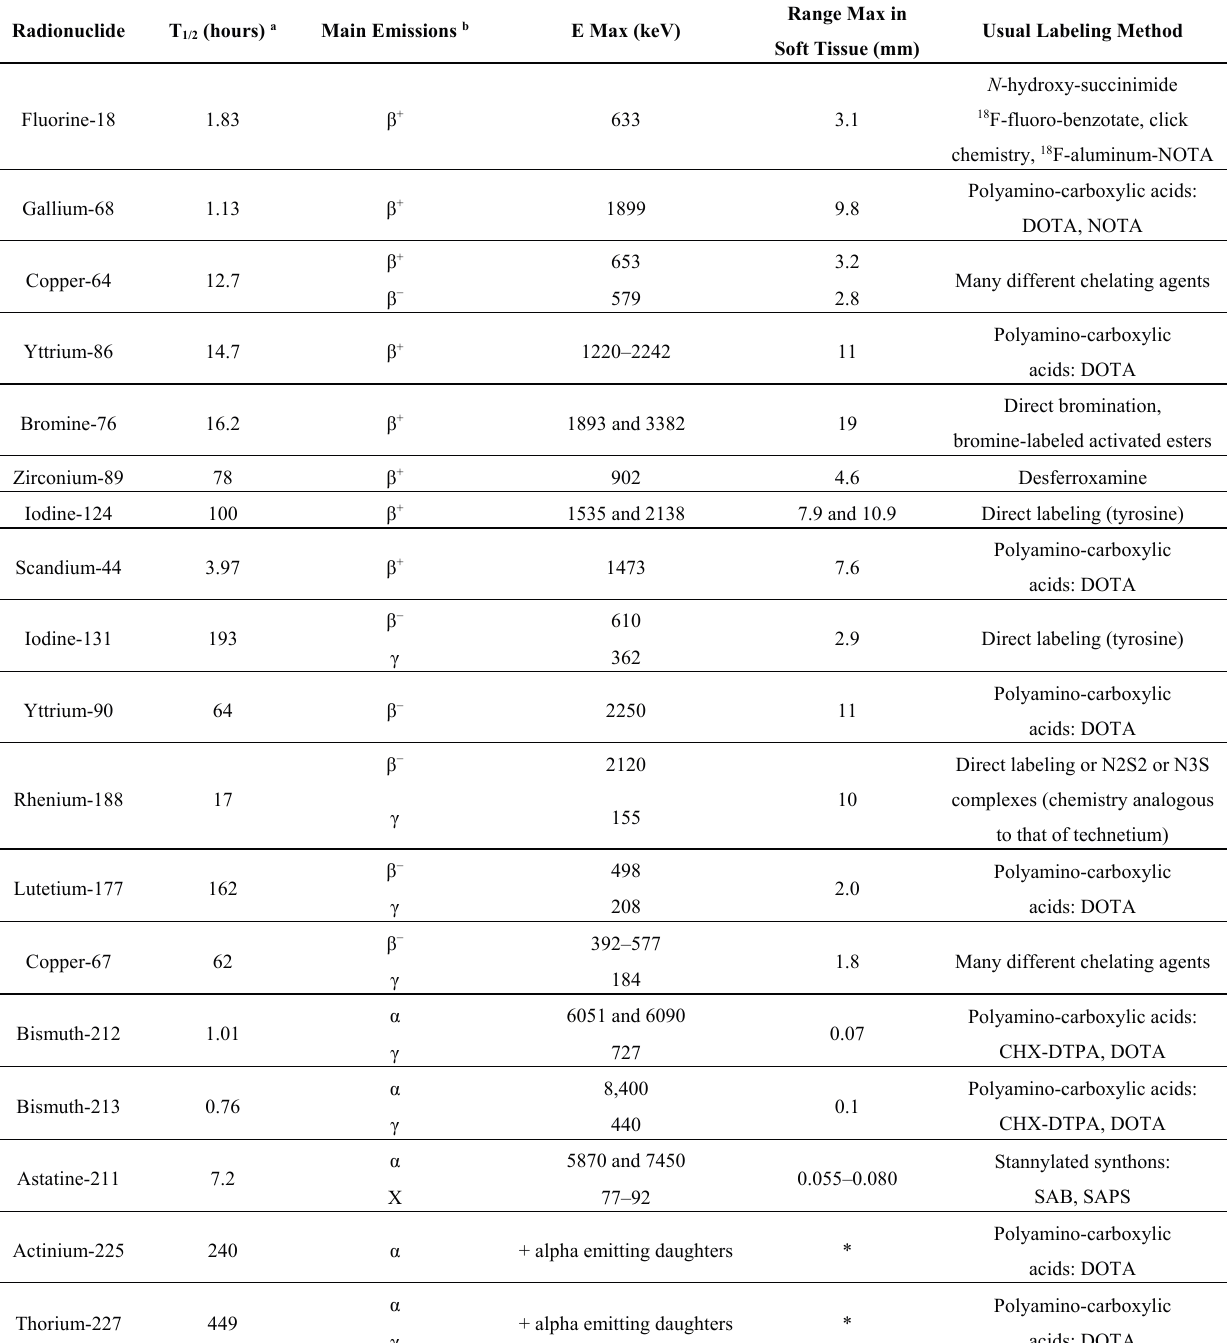
Table 1. Radionuclides for antibody-targeted imaging and